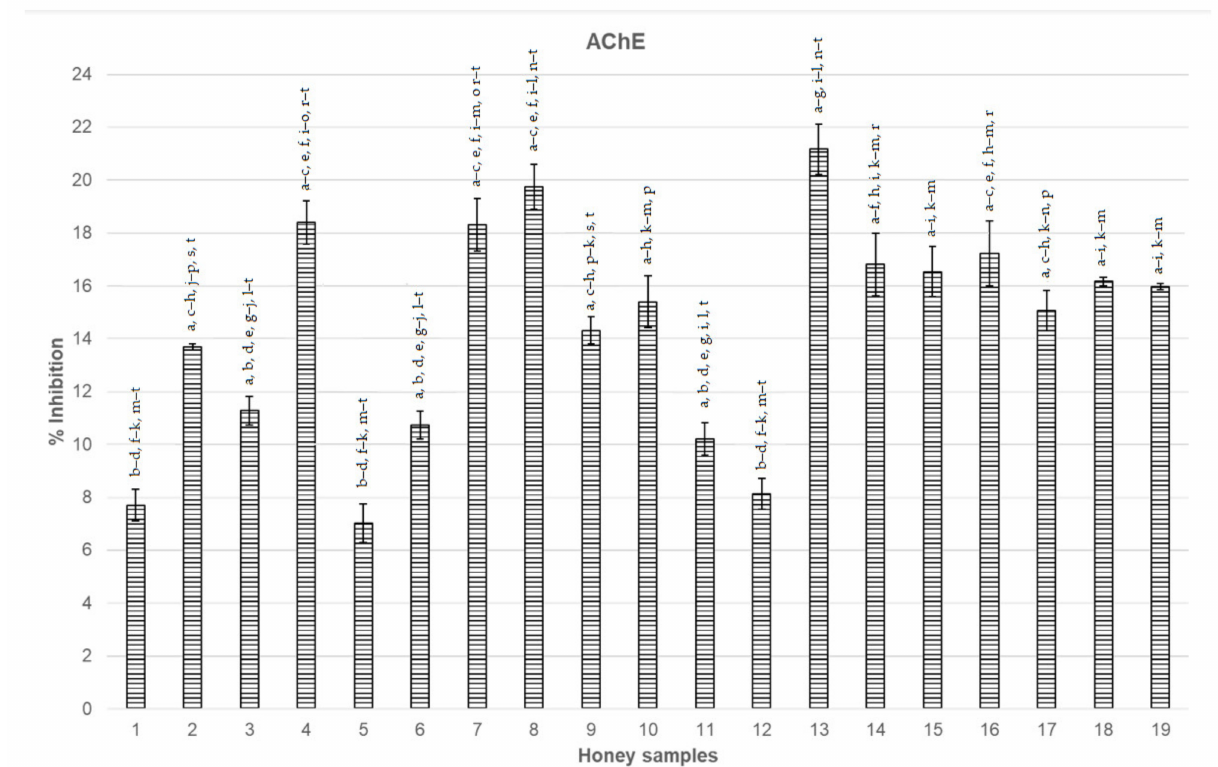
Figure 2. AChE inhibition (%) in the studied honeys (averaged results ± standard